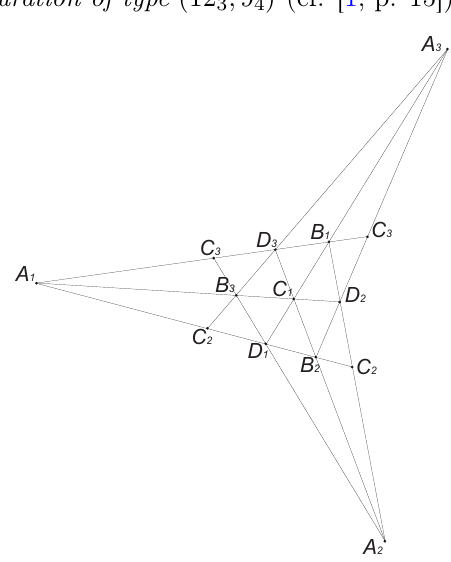
Fig. 1. H ´ T modified as special Pappus